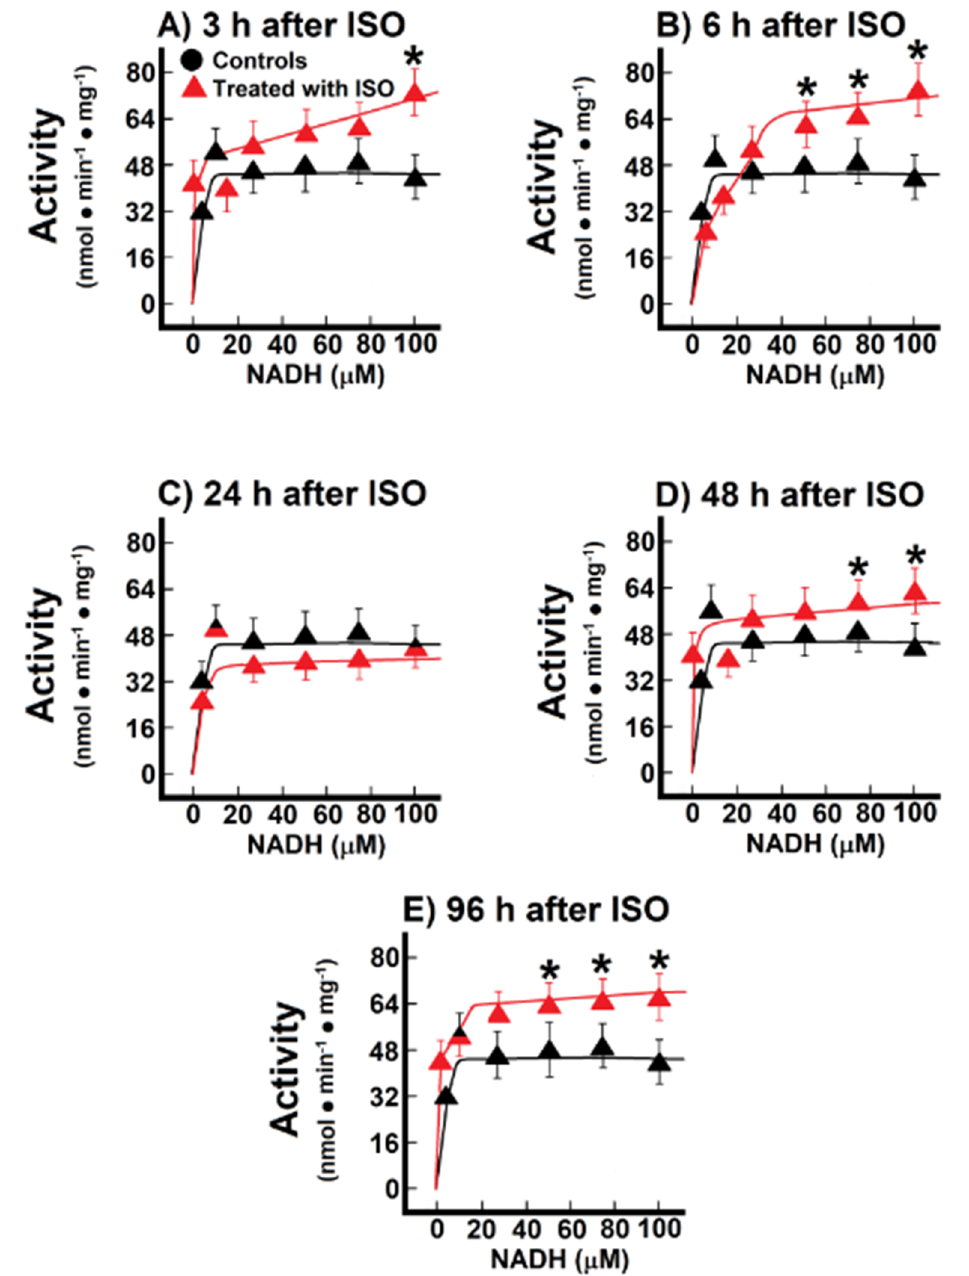
Figure 5. Temporal course of malate-aspartate shuttle at 3 h (Panel ( A )), 12 h (Panel ( B )), 24 h (Panel ( C )), 48 h (Panel ( D )) and 96 h (Panel ( E )) after ISO treatment. Changes of the activity of the malate-aspartate shuttle during induction of myocardial infarction. Results are expressed as mean ± S.E. of three control animals and five rats treated with ISO per experimental point of the kinetics of the endogenous NADH oxidation. Symbols for the experimental groups at the top of panel ( A